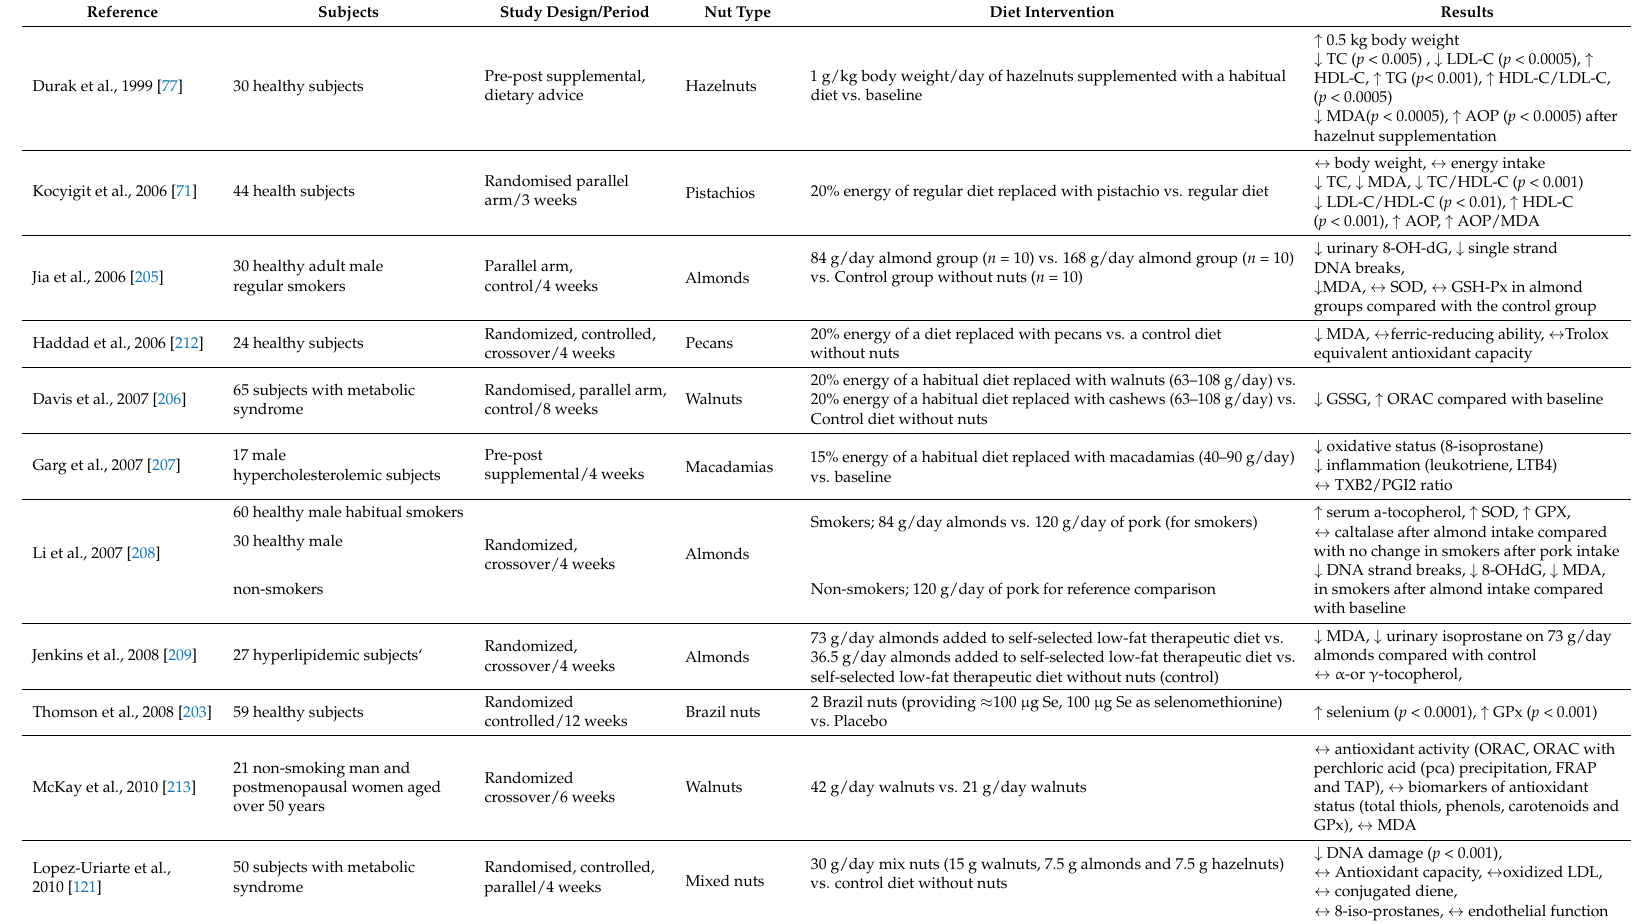
Table 4. Summary of clinical trials examining the effect of nut consumption on oxidative